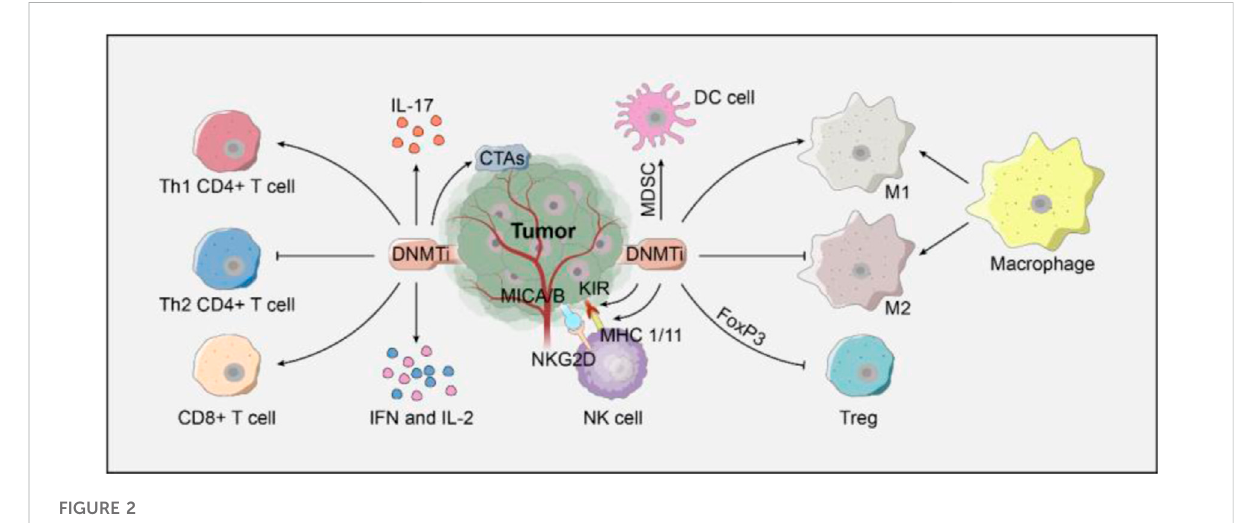
FIGURE 2 Regulation of DNMTis on immune